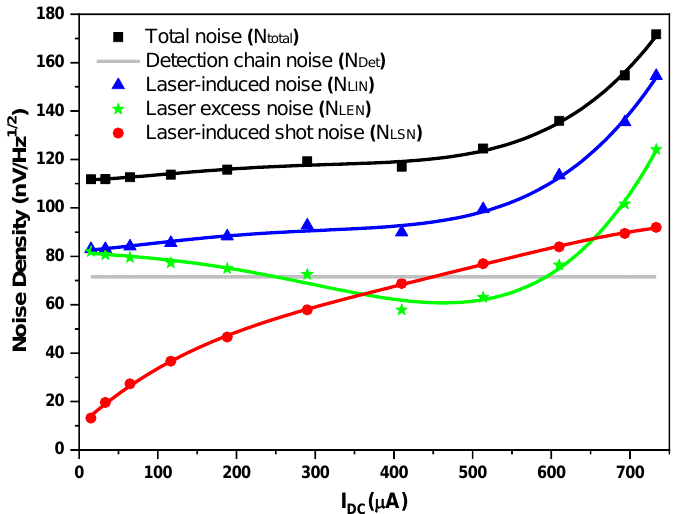
Figure 5. Plots of measured system total noise density N total , detection chain noise density N Det , laser-induced noise density N LIN , laser-induced shot-noise density N LSN , and laser excess noise density N LEN vs. LO photocurrents, respectively.